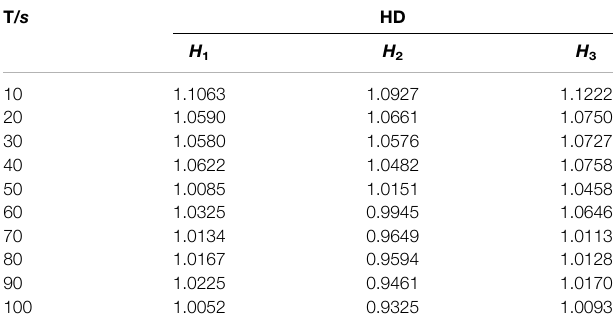
TABLE 6 | Healthy degree of engine equipment from normal operation to fault